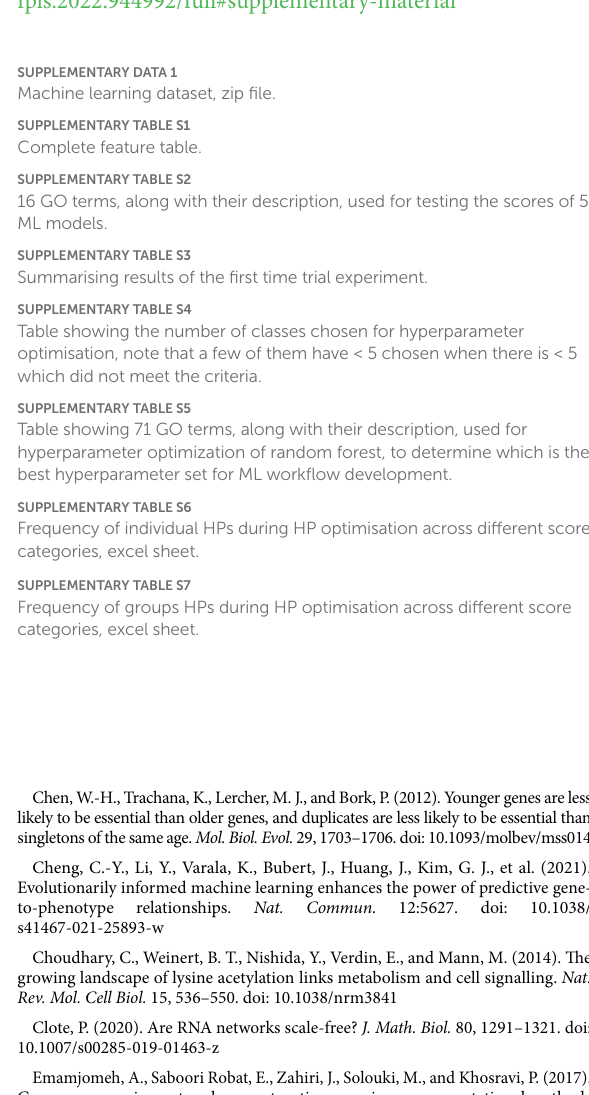
SUPPLEMENTARY DATA 1 Machine learning dataset, zip file. SUPPLEMENTARY TABLE S1 Complete feature table. SUPPLEMENTARY TABLE S2 16 GO terms, along with their description, used for testing the scores of 5 ML models. SUPPLEMENTARY TABLE S3 Summarising results of the first time trial experiment. SUPPLEMENTARY TABLE S4 Table showing the number of classes chosen for hyperparameter